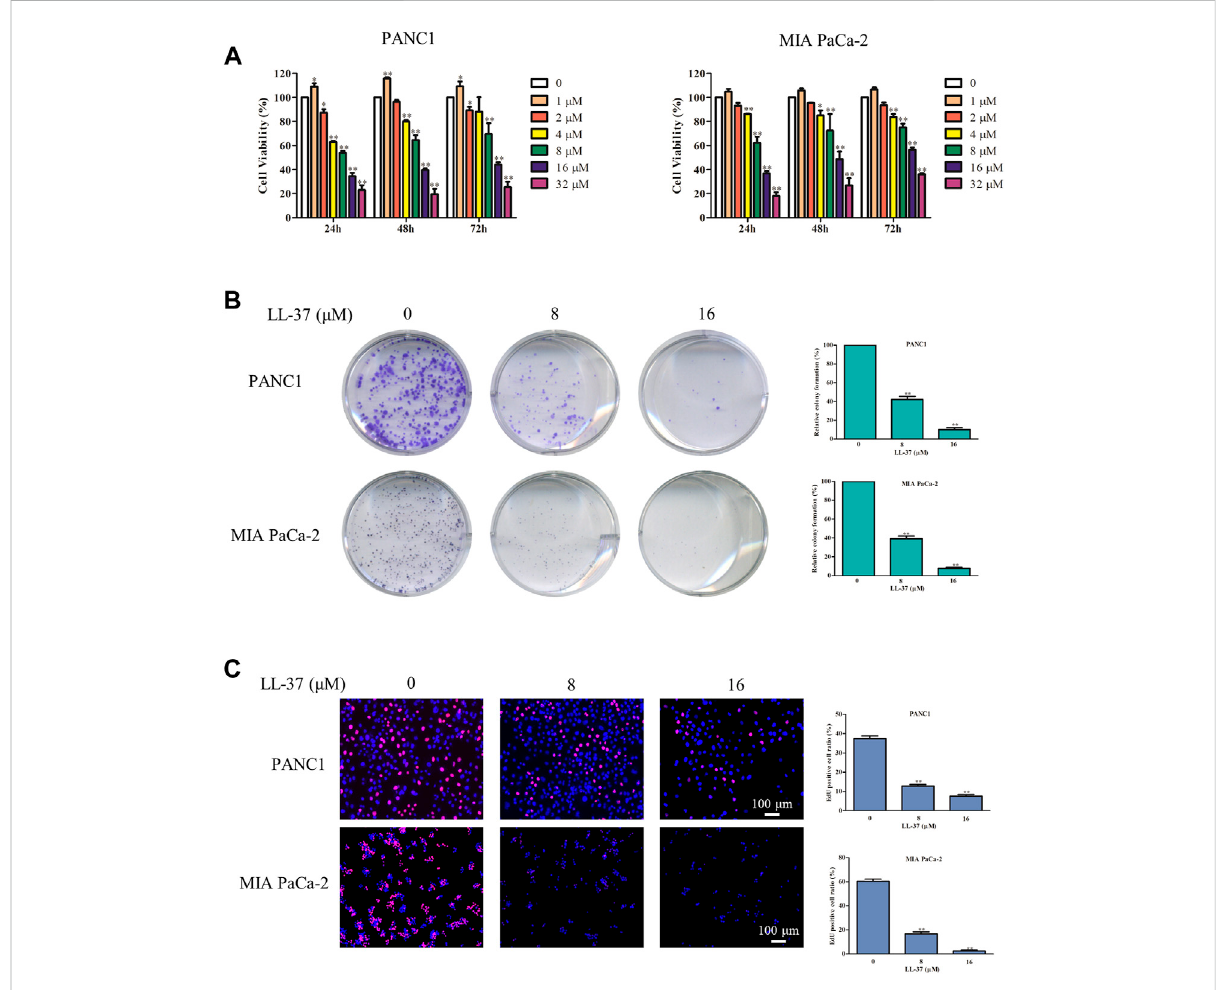
FIGURE 1 LL-37 inhibits the growth of pancreatic cancer cells. (A) The cell viability of human PANC1 and MIA PaCa-2 cells treated with various concentrationsofLL-37(1 – 32 μ M)for24,48or72 hwasdeterminedbyMTTassay. (B) Colonyformationassaywasusedtoevaluatetheproliferation ability of PANC1 and MIA PaCa-2 cells. (C) The proliferation of PANC1 and MIA PaCa-2 cells was detected by EdU staining (red). DAPI (blue) stained the nuclei. Cells treated with DMSO were used as negative controls. The data of all drug treatment groups were normalized to the